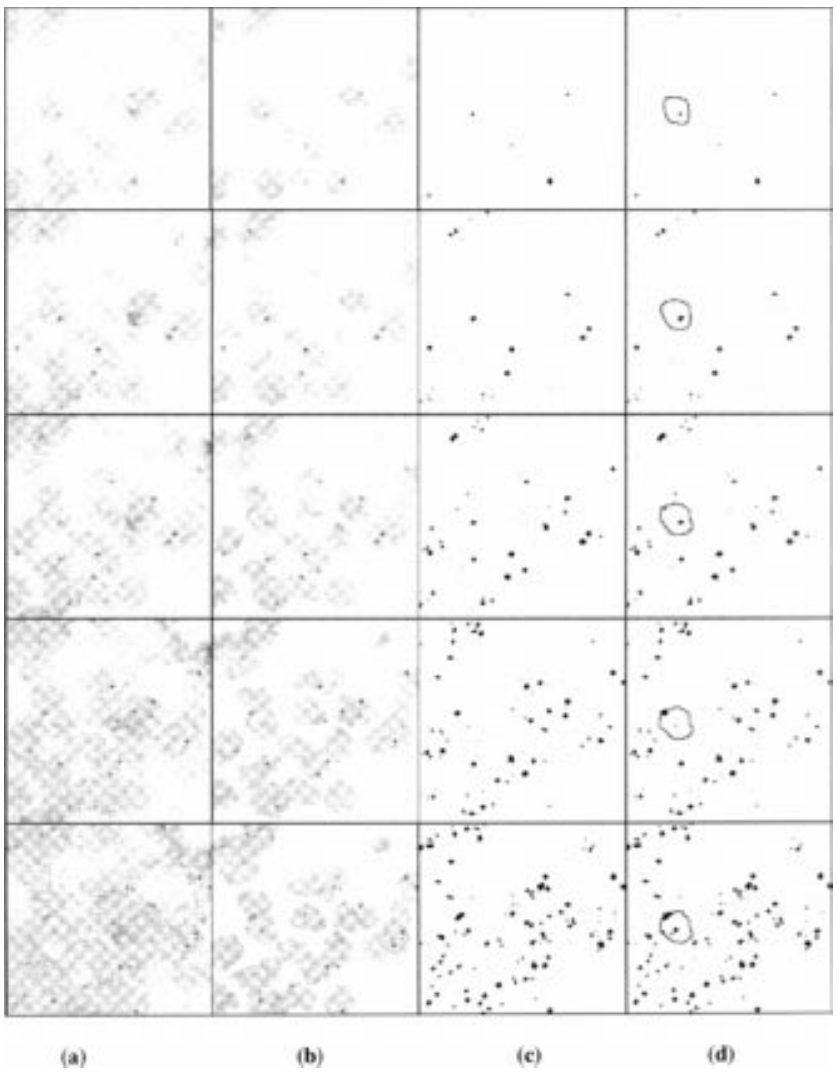
Fig. 8. Result of segmentation and counting of FISH signals. (a) Unprocessed FISH signal channel; (b) after noise reduction; (c) after signal enhancement by top-hat filtering; (d) signal channel with a overlaid cell